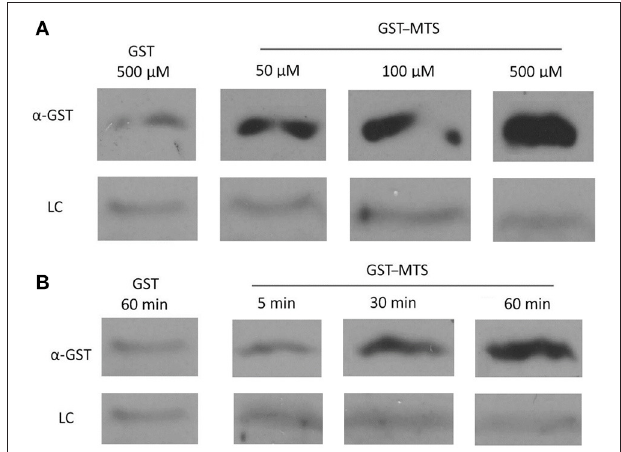
FIGURE 5 | Uptake of a GST-Membrane transport signal (MTS) fusion protein into EBs. EBs were purified on a discontinuous gastrografin gradient and collected by centrifugation to ensure the use of a homogenous EB mixture. The GST alone and GST–MTS protein was expressed in Escherichia coli cells and purified using glutathione beads. The EBs were then incubated with either GST or GST–MTS, trypsinized for 30min to ensure that all extracellular GST or GST–MTS was degraded, and examined by α -GST Western blot for the presence of intracellular GST-tagged protein. CdsL, an intracellular type III secretion protein, was used as a loading control (LC). (A) Time-course for incubation of EBs with GST–MTS for 5, 30, or 60min. GST control at 60min displayed very little protein while GST–MTS at 5, 30, and 60min had increasing amounts of GST–MTS present within the EBs. (B) Dose–response of EBs incubated with GST–MTS at 50, 100, and 500 µ m. GST control at 500 µ m displayed very little protein while GST–MTS accumulated within the EBs as the concentration increased. CdsL is shown as a